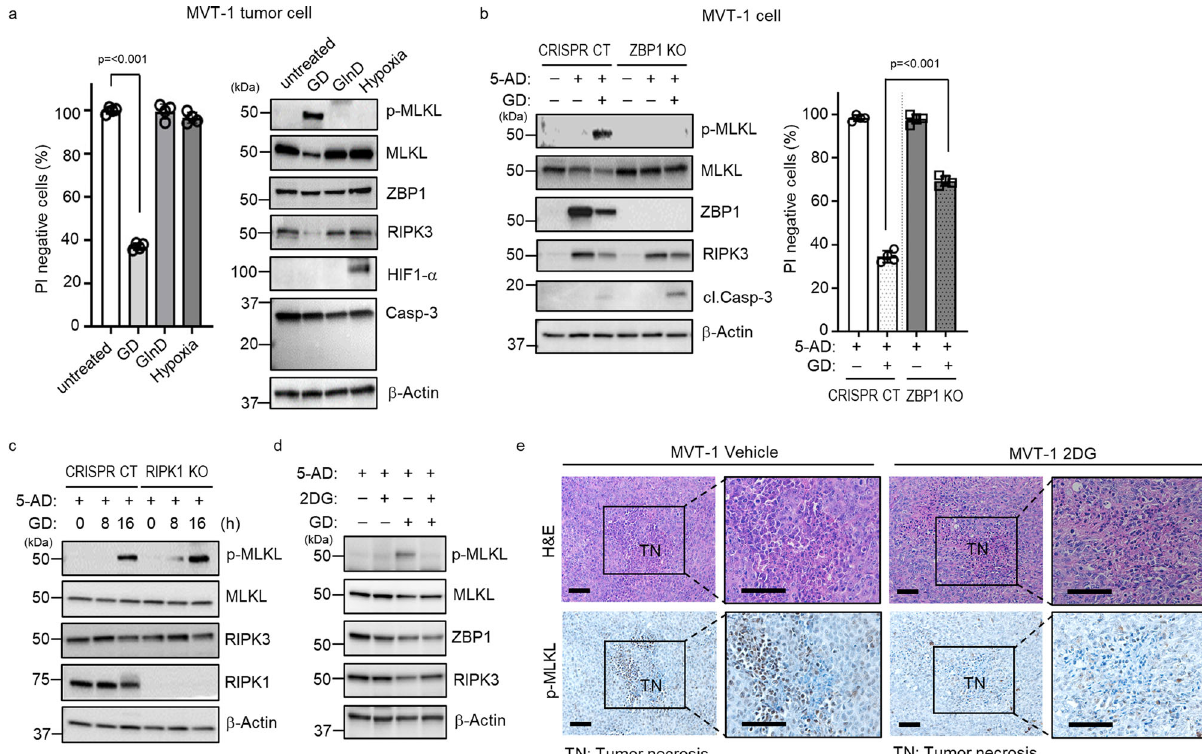
Fig. 4 Glucose deprivation (GD) induces tumor necroptosis in vitro and in vivo. a Primary MVT-1 tumor cells were isolated at 5 weeks post-implantation and treated for 36 h with 0.5 mM glucose (GD) or 0.1 mM glutamine (GlnD) or 0.1% O 2 (hypoxia) and cell death was determined by PI staining using fl ow cytometry (left panel, n = 4 biologically independent samples, each) or representative of three independent experiments analyzed by western blotting using the indicated antibodies (right panel). Data are presented as mean values ± SEM. b Representative of three independent western blotting analysis. MVT-1 CRISPR CT or MVT-1 ZBP1 KO cells were treated with 5-Aza-2 ′ -deoxycytidine (5-AD), for 3 days, followed by GD condition for 24 h (left panel) and determined by using the indicated antibodies. Cell death analysis of the cells treated with 5-AD for 3 days, followed by GD condition for 30 h, was determined by PI staining using fl ow cytometry (right panel, n = 4 biologically independent samples, each). Data are presented as mean values ± SEM. c Representative of three independent western blotting analysis. MVT-1 CRISPR CT or MVT-1 RIPK1 KO cells were treated with 5-AD for 3 days, followed by GD condition for the indicated time points and determined by using the indicated antibodies. d Representative of three independent western blotting analysis. MVT-1 cells were treated with 5-AD for 3 days, followed by treatment with 2-Deoxy-D-glucose (2DG) and determined by using the indicated antibodies. e FVB/NJ mice at three weeks post-implantation with MVT-1 cells were treated with vehicle or 2DG ( i.p .) daily until week 5. Representative images of H&E and immunohistological stained sections with phospho-MLKL (p-MLKL) antibody. Scale bar, 50 µ m. Two-sided student ’ s t test was used to determine the statistical signi fi cance of differences between groups. Differences with P values < 0.05 were considered signi fi cant. Source data are provided as a Source Data fi